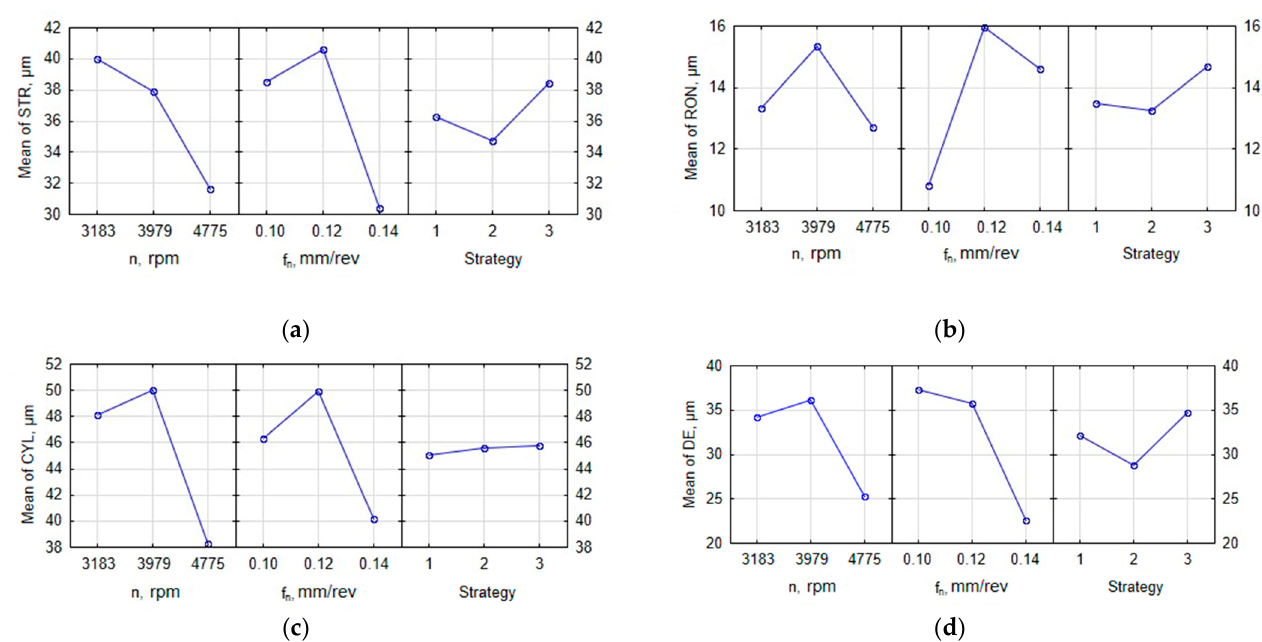
Figure 5. Main effects plots: ( a ) straightness error, ( b ) roundness error, ( c ) cylindricity error, and ( d ) diameter error.